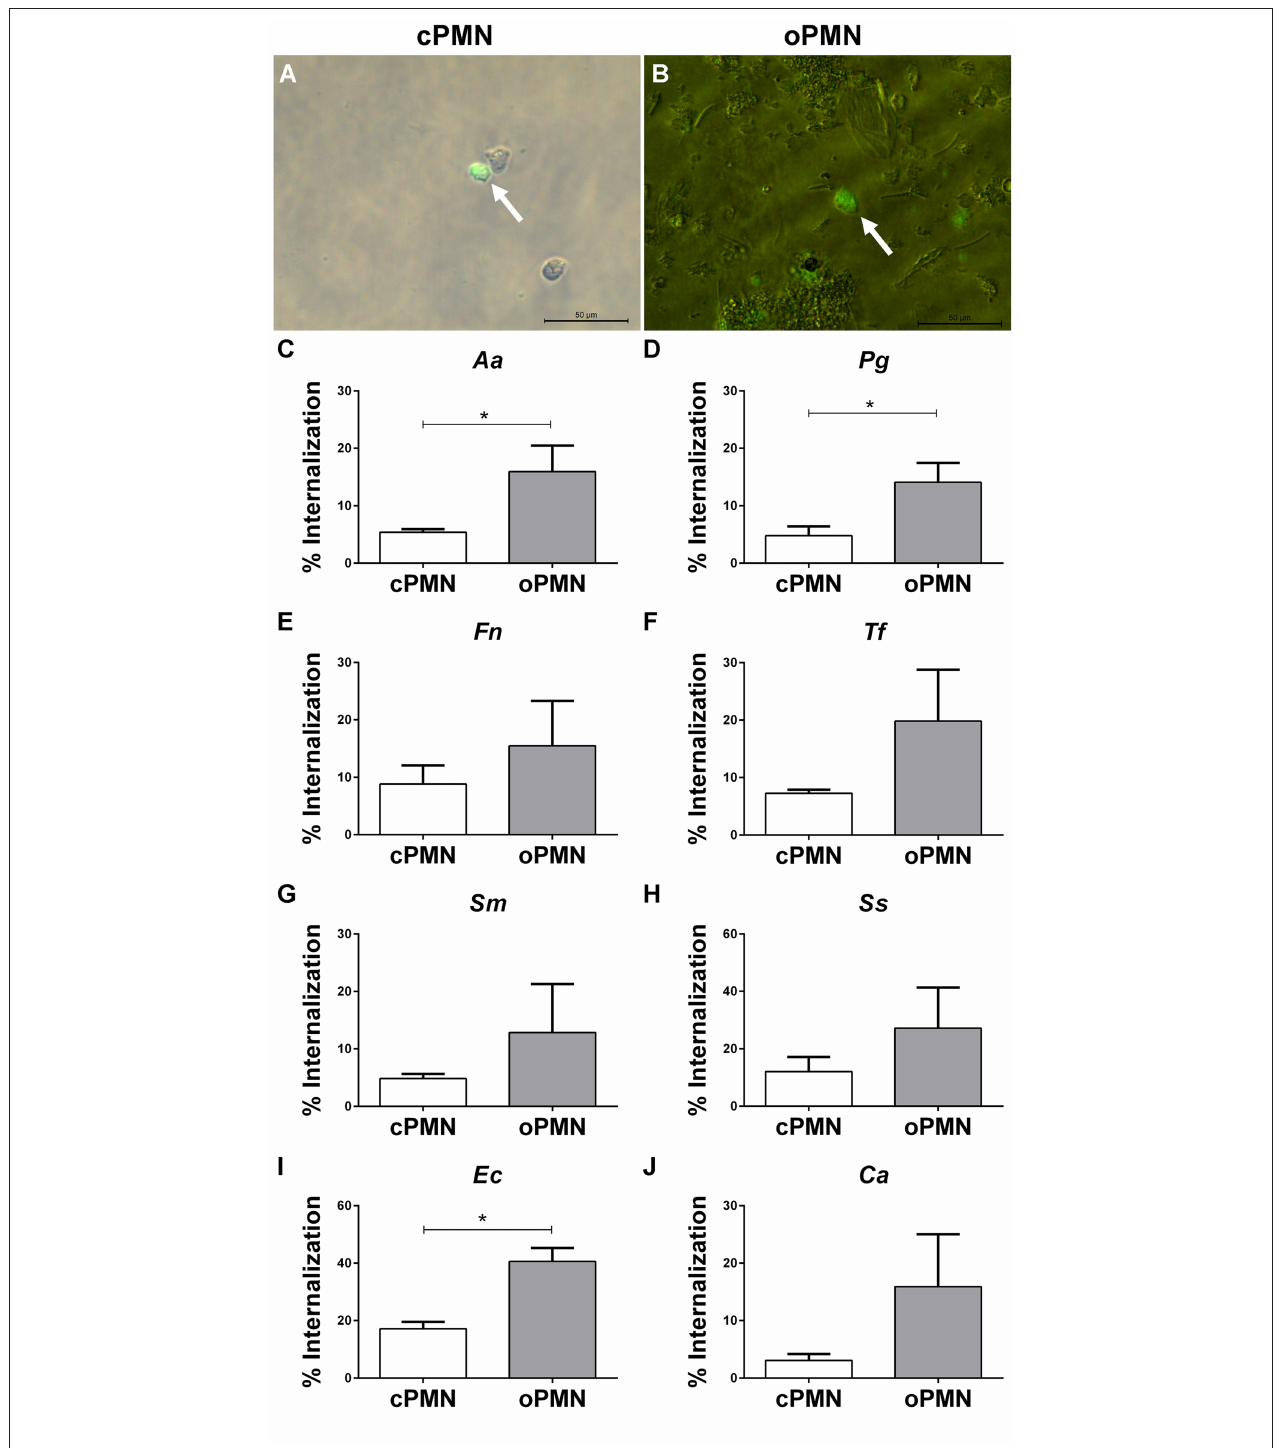
FIGURE 5 | Internalization by cPMNs and oPMNs . Micrographs of FITC labeled internalization by cPMNs (A) and oPMNs (B) . White arrows depict adhesion of FITC labeled bacteria ( Fusobacterium nucleatum ) which are shown in green. All micrographs are representatives of 3 independent experiments. Scales represent 50 µ M. Quantitative analysis of internalization of heat-inactivated A. actinomycetemcomitans [ Aa, (C) ], P. gingivalis [ Pg , (D) ], F. nucleatum [ Fn , (E) ], T. forsythia [ Tf, (F) ], S. mutans [ Sm, (G) ], S. Sanguinis [ Ss , (H) ], E. coli [ Ec, (I) ], and C. albicans [ Ca, (J) ] by cPMNs (white bars) and oPMNs (gray bars). The gating strategy presented in Supplementary Figure 3 was employed for all quantifications. Data are presented as mean ( + SEM) percentages of internalization, note the variation in y-axis scales. n = 3, * p < 0.05.